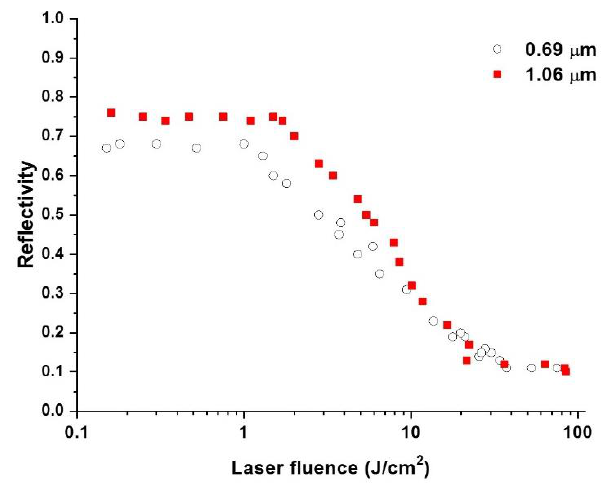
Figure 2. Experimental reflectivity values for bulk niobium when irradiated by laser wavelengths λ = 1.06 and 0.69 µm in air at atmospheric pressure.